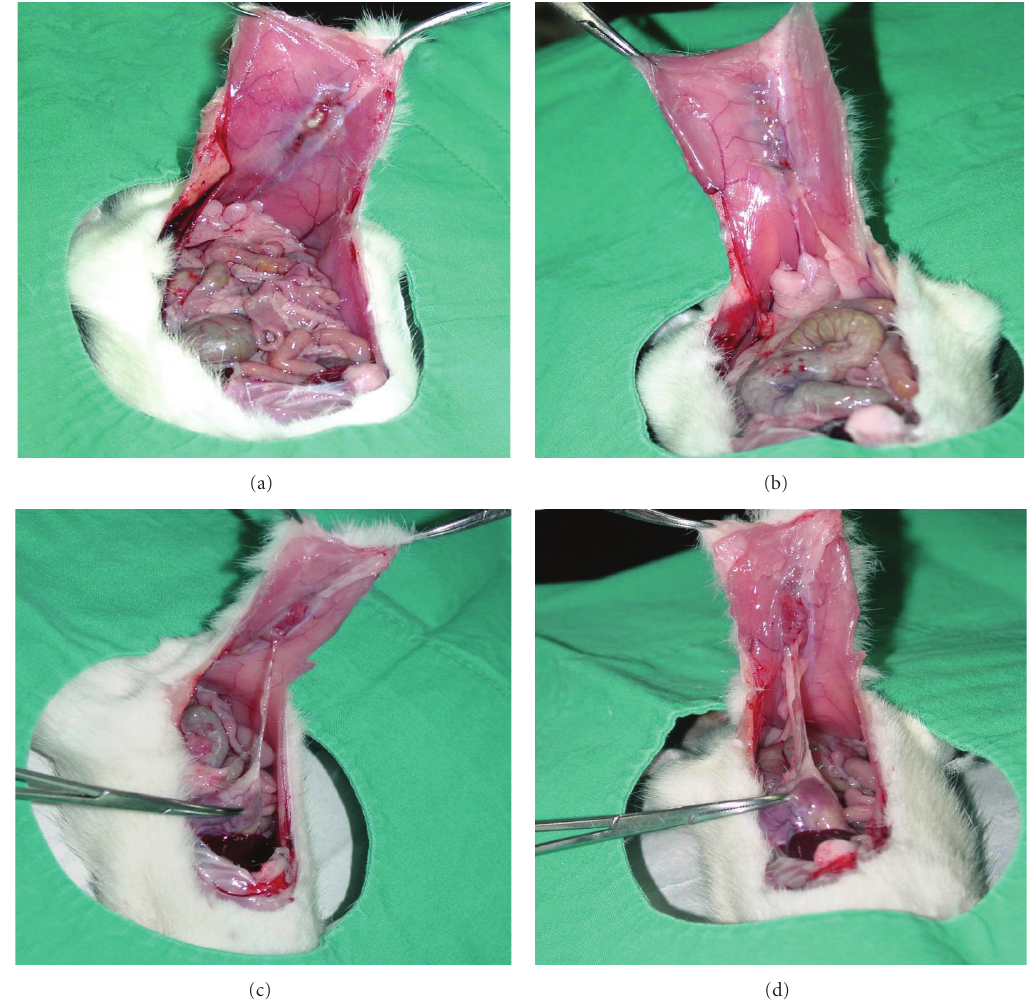
Figure 1: Appearance of peritoneal adhesions in rats. Grade 0 (a), I (b), II (c), and III (d)